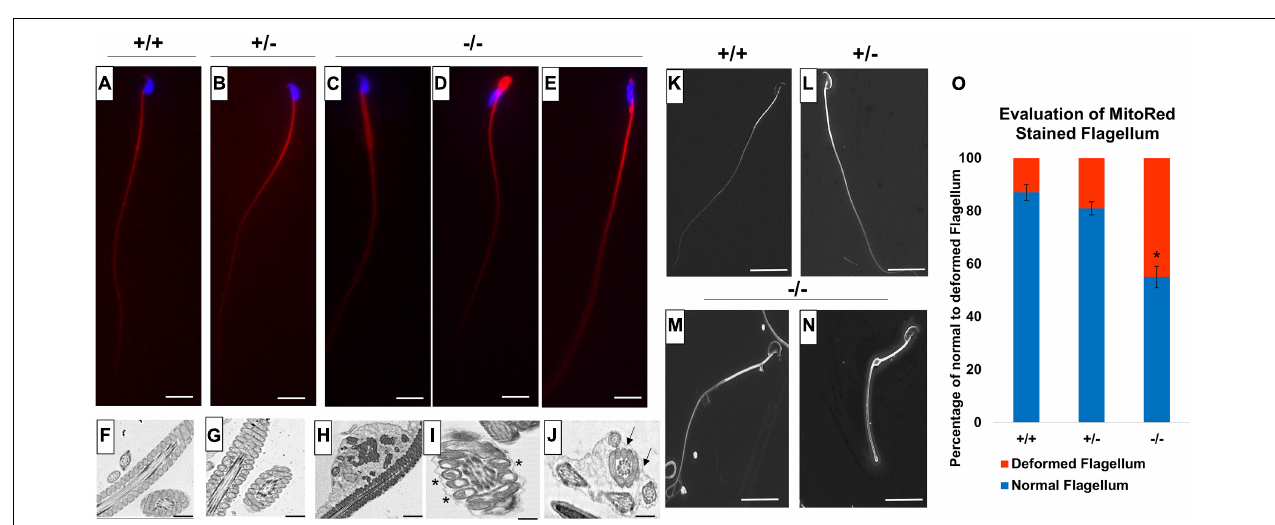
FIGURE 12 | Flagellum analysis on mature sperm cells from Pfn3 + / + , Pfn3 + / − , and Pfn3 − / − mice. Mito Red staining (red) of sperm flagellum on (A) Pfn3 + / + ;